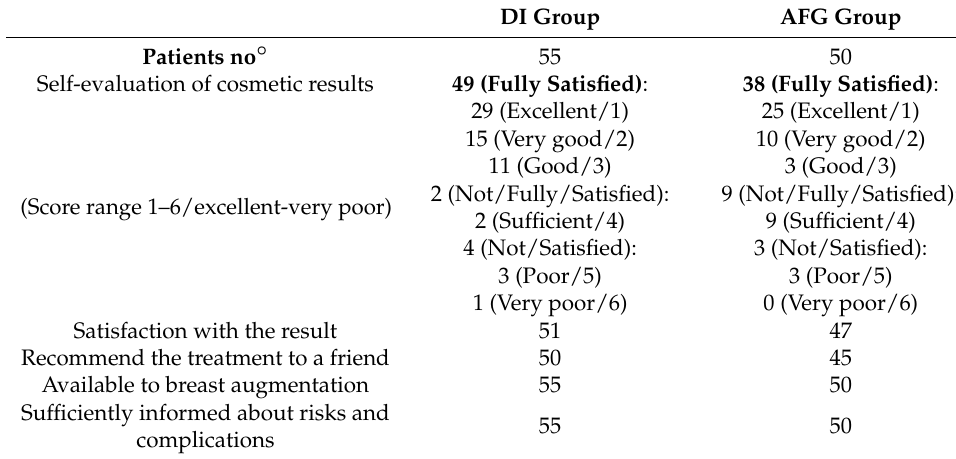
Table 4. Patient satisfaction